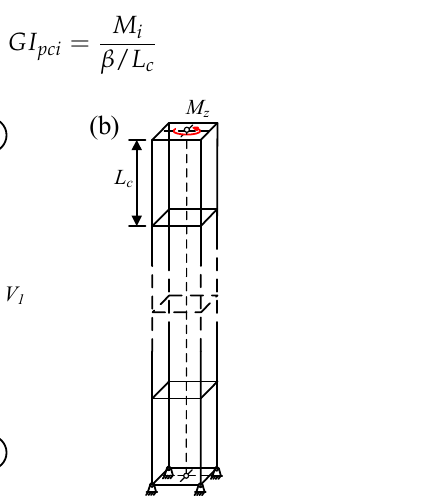
Figure 6. Torsion diagram ( a ) of a typical cross-section in the equivalent straight truss ( b ) considering the shear deformation of chords.